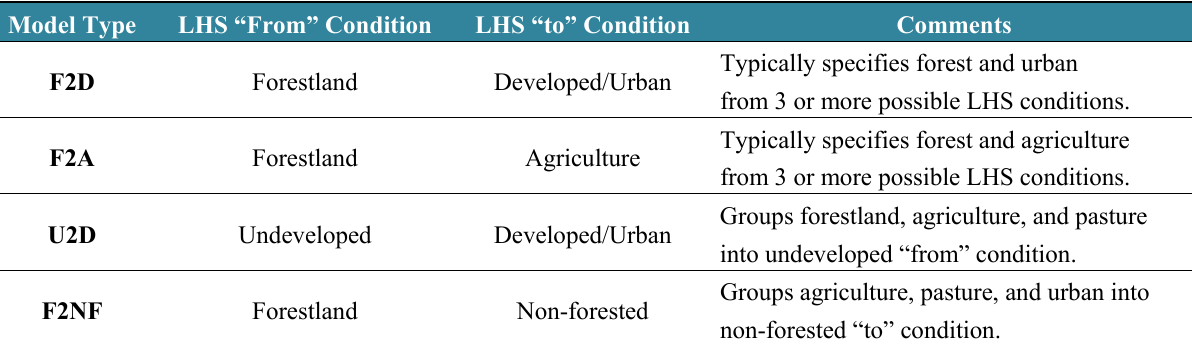
Table 1. Brief description of four model types and left hand side (LHS) conditions accepted in meta-analysis of econometric models predicting forest land use and land cover (LULC)